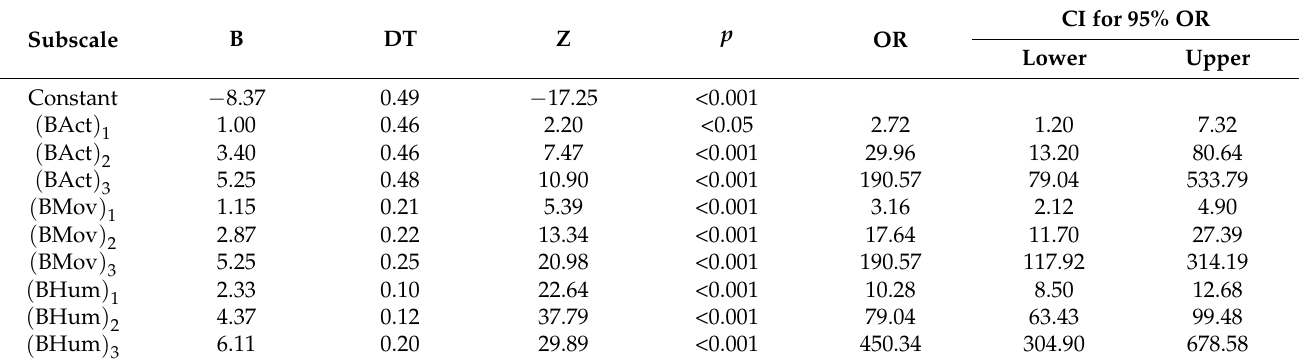
Table 4. Prognosis model for pressure ulcer (PU) based on activity, mobility, and skin moisture subscales.